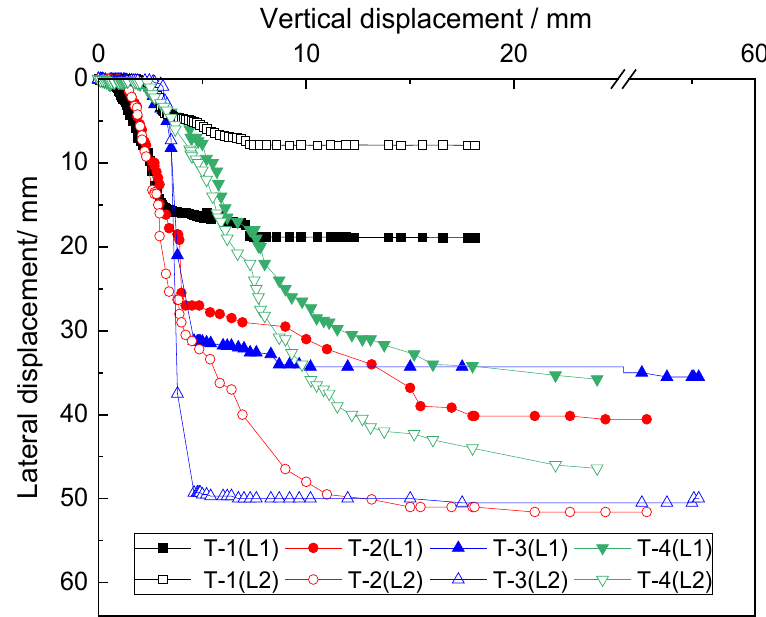
Figure 3. Variation of lateral displacement of the slope with its vertical displacement.